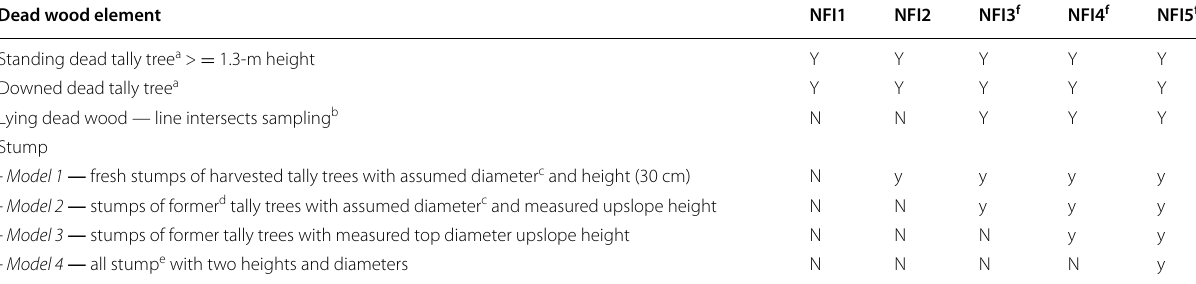
Table 1 Available measurements of dead wood elements and temporally consistent stump volume models throughout five Swiss National Forest Inventories (NFI1 to